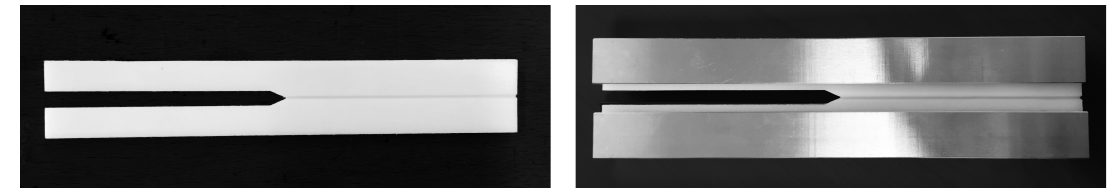
Figure 5. Specimen in mode I investigation ( left ) and mode III investigation ( right ). In mode I,